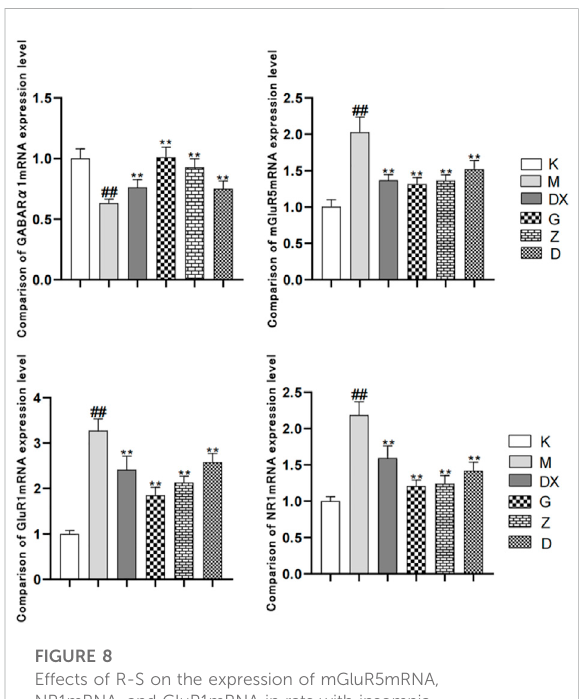
FIGURE 8 Effects of R-S on the expression of mGluR5mRNA, NR1mRNA, and GluR1mRNA in rats with